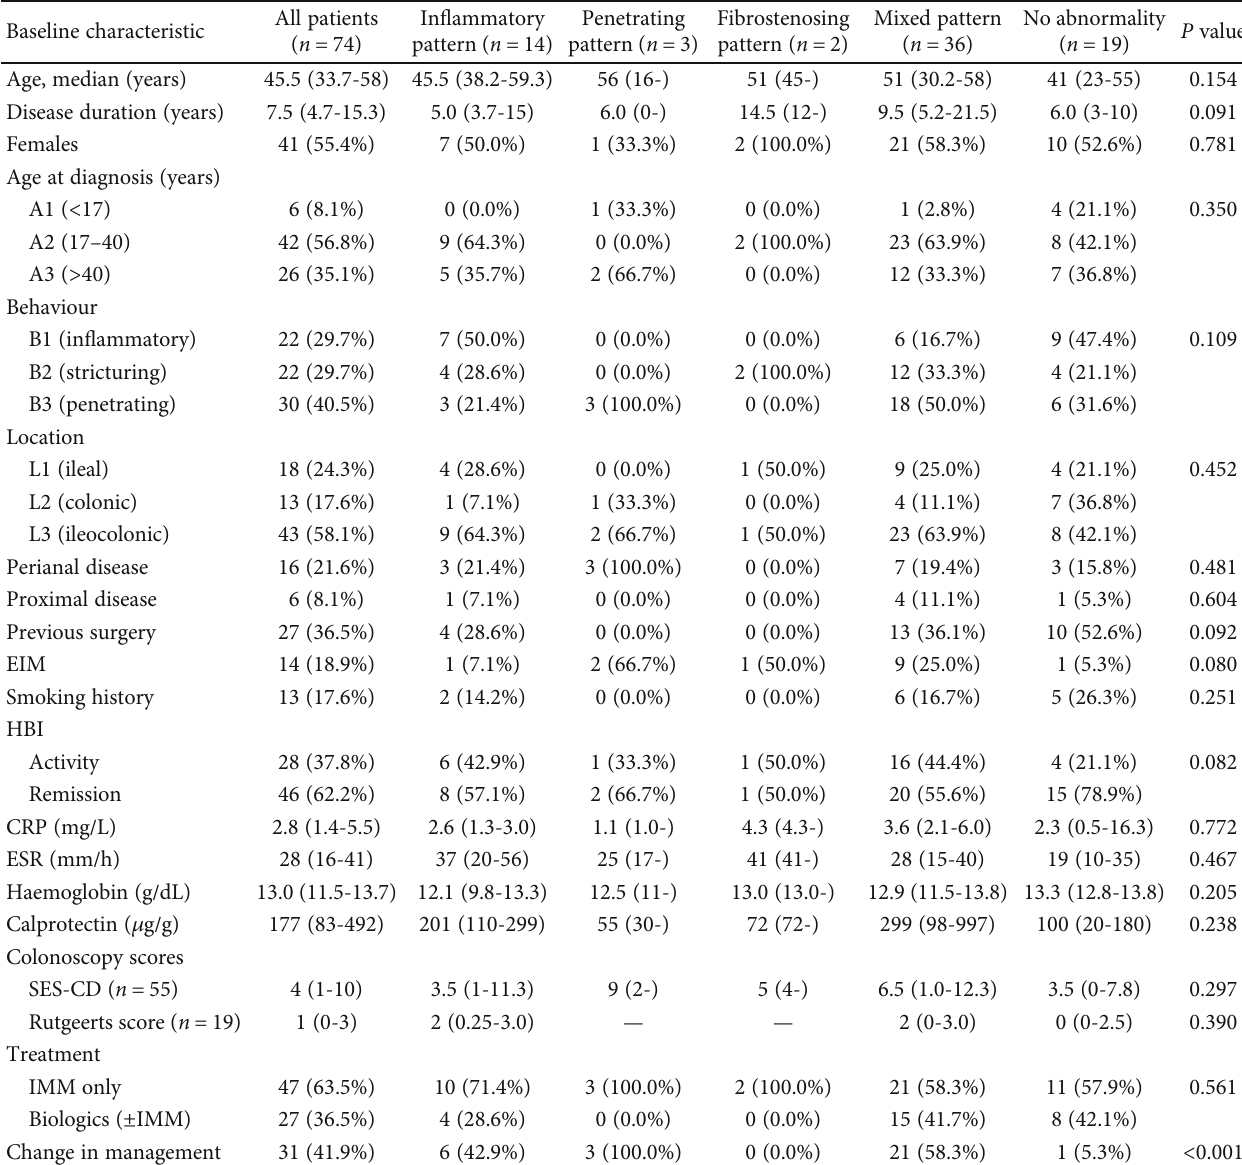
Table 1: Characteristics of the patients and disease strati fi cation based on magnetic resonance enterography. Baseline characteristic